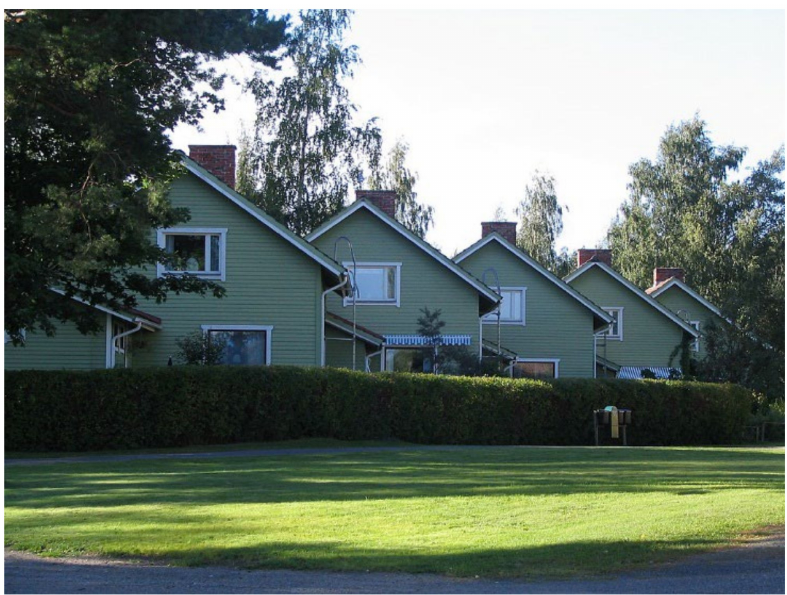
Figure 1. Typical Finnish post-World War II single-family houses in Jyväskylä, Finland (Source: Wikipedia).